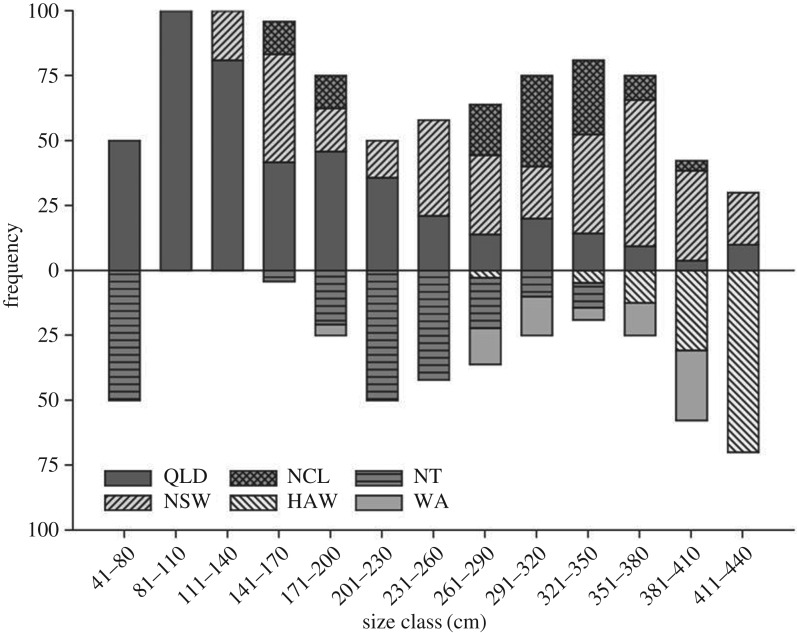
Length-frequency distribution of G. cuvier from which tissues were sampled in the Indo-Pacific region. No length measurements were recorded for Coral Sea samples.